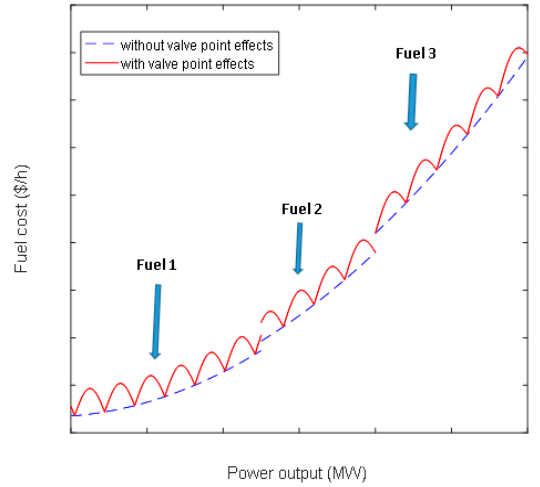
Figure 2. Fuel cost function for the case of multi-fuel options.